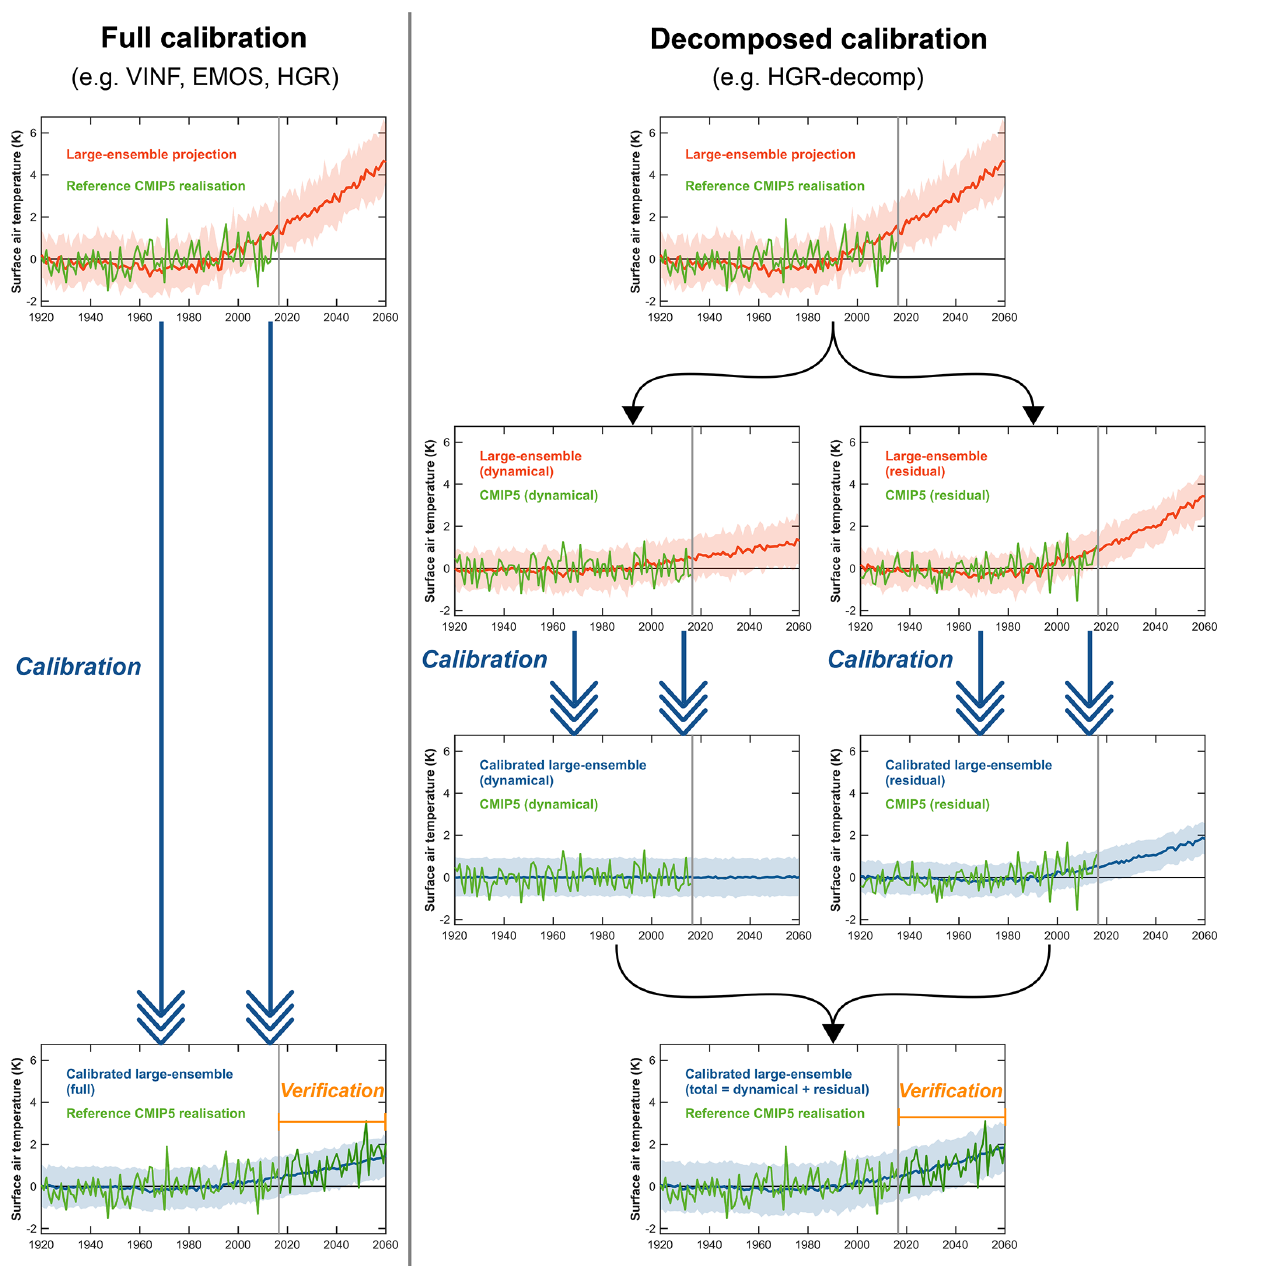
Figure 3. An example showing the steps of the full calibration methods (left-hand column) and calibration of the dynamically decomposed variables (right column). This example is the calibration of the summer (JJA) Central European (CEUR) temperature using the CESM1-LE and one of the CMIP5 models. The shading shows the 5–95% range of the CESM1-LE ensemble. The effectiveness of the calibration is assessed by verifying over data from the period 2017–2060, which is withheld during the calibration